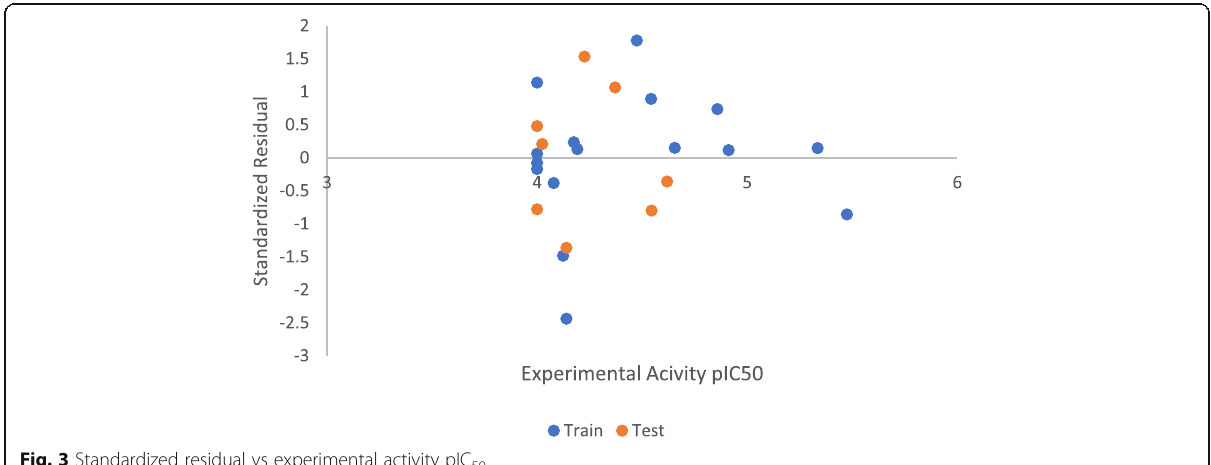
Fig. 3 Standardized residual vs experimental activity pIC